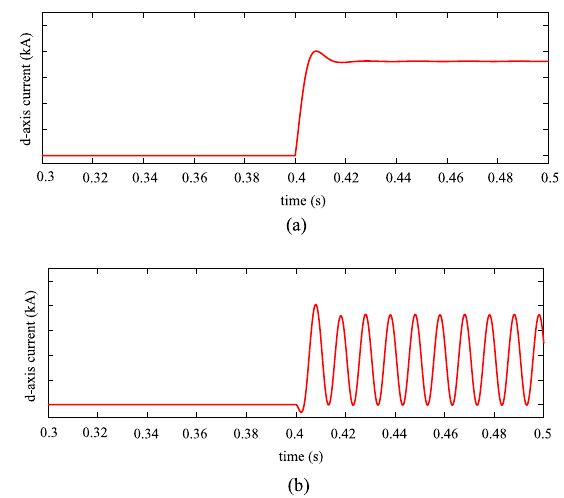
Fig. 5 D-axis current waveforms of synchronous motor after the fault ( a ) Symmetrical fault ( b ) Asymmetrical fault